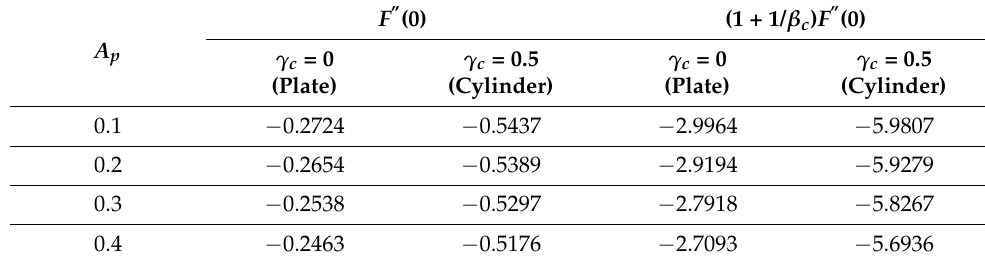
Table 3. Variation in SFC for A p